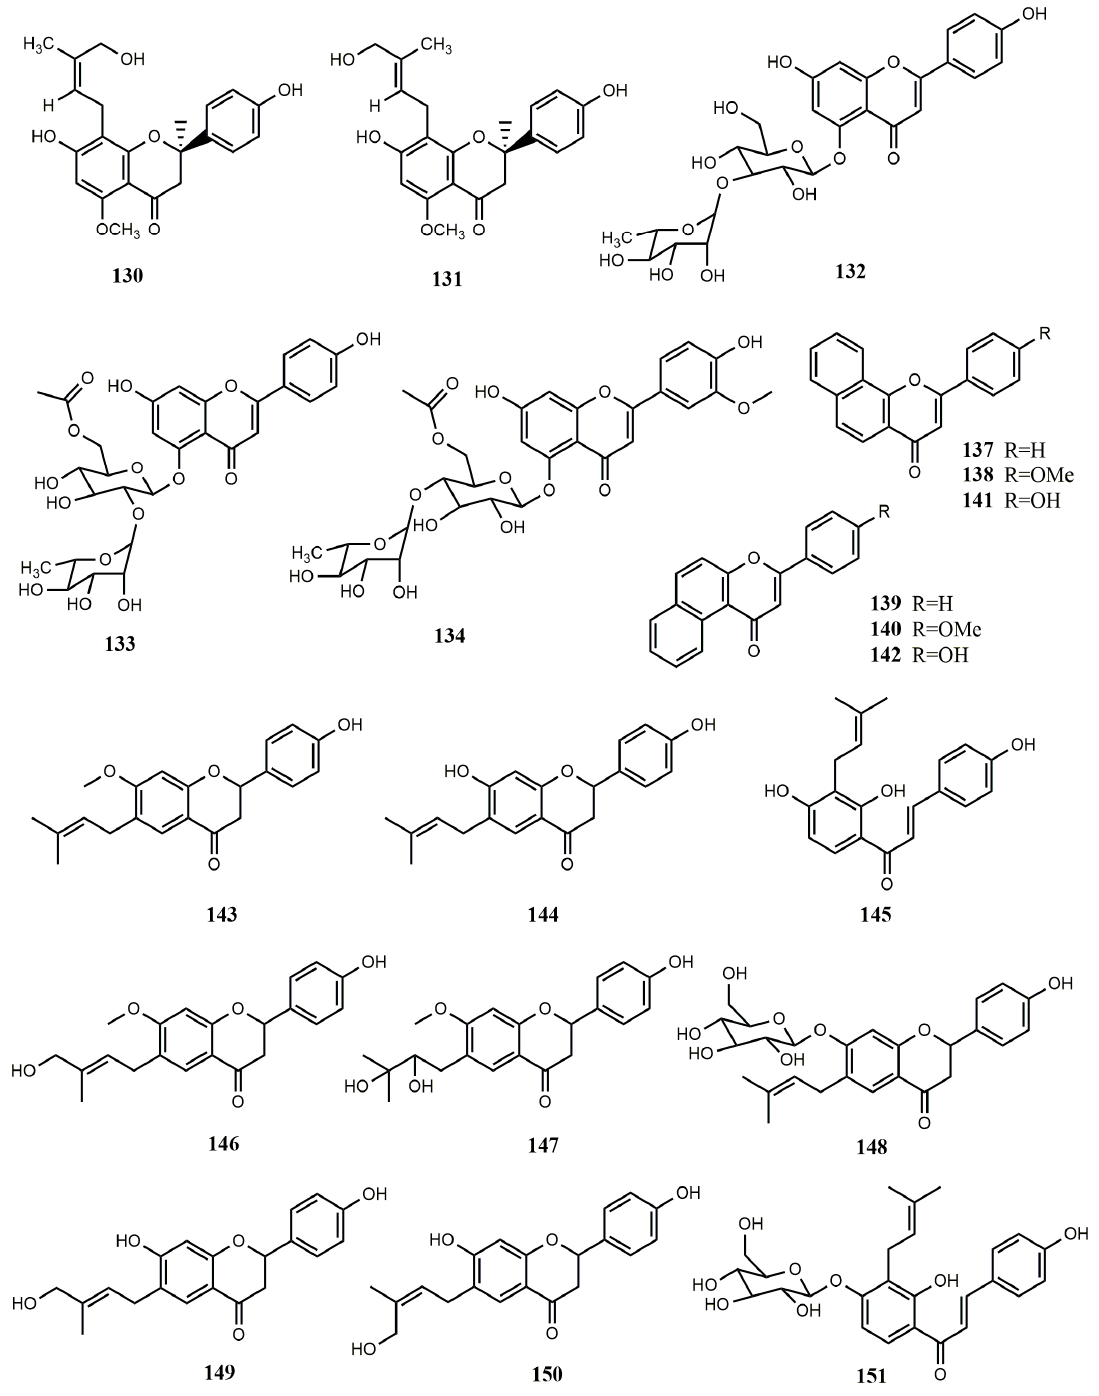
Figure 7. Biotransformation of isoflavones and flavonoids 83 – 251 by fungi.